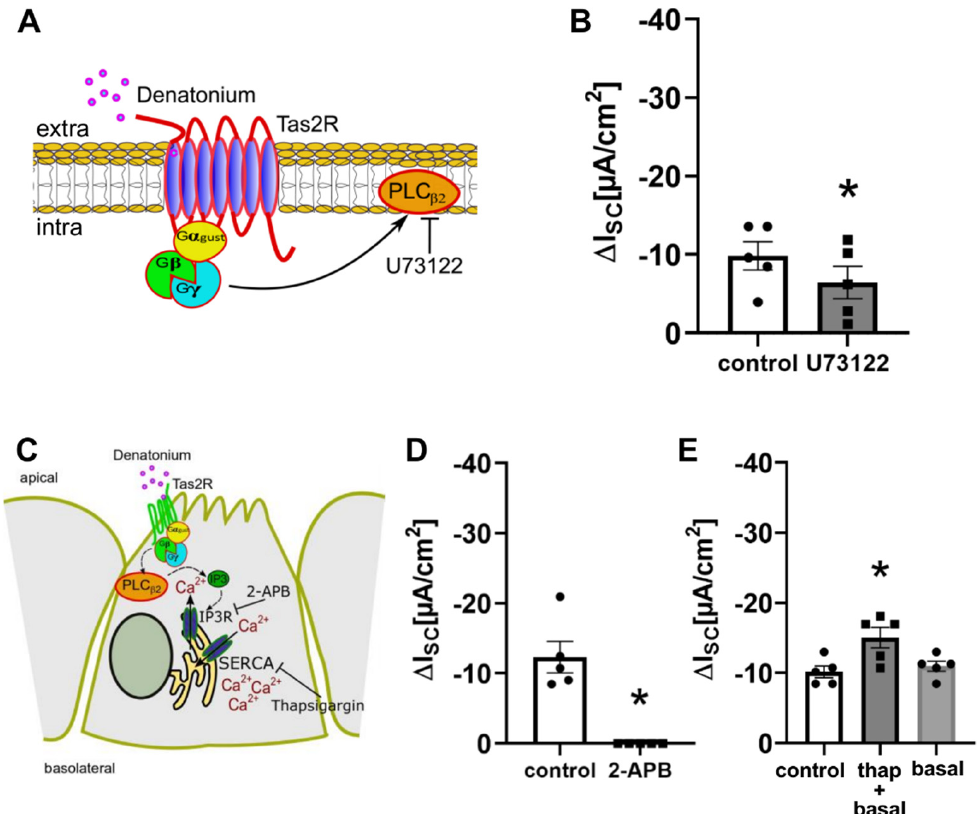
Figure 4. Involvement of components of the canonical bitter taste signalling cascade in the denatonium-induced effect. ( A ) Schematic drawing of the action of the PLC β 2 inhibitor U-73122. ( B ) In the presence of the PLC β 2 inhibitor U-73122 (10 µ M, apical), the denatonium-induced current was reduced compared to control conditions ( ∆ I SC , n = 5, * p < 0.05). ( C ) Schematic drawing of the influence of the 1,4,5-trisphosphate (IP3) receptor inhibitor 2-APB, the gap junction inhibitor carbenox- olone and the SERCA inhibitor thapsigargin. ( D ) The IP3 receptor inhibitor 2-aminoethoxydiphenyl borate (2-APB, 100 µ M, apical) reduced the denatonium-induced effect ( ∆ I SC , n = 5, * p < 0.05). ( E ) Depletion of endoplasmic reticulum Ca 2+ stores with 1 µ M thapsigargin (thap, apical) in the presence of extracellular Ca 2+ did not impact the denatonium-induced effect ( ∆ I SC , n = 5, * p < 0.05). Control: denatonium-effect without thapsigargin, thap + basal: denatonium-effect in the presence of thapsigargin, basal: denatonium-effect in the presence of thapsigargin without the thapsigargin- induced increase of basal I SC .